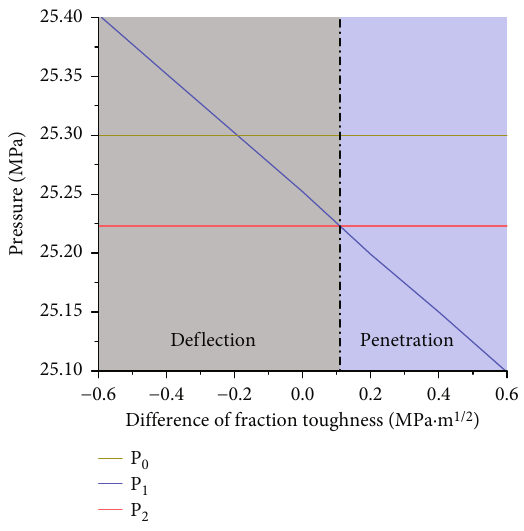
Figure 5: Changes in P toughness di ff erences.